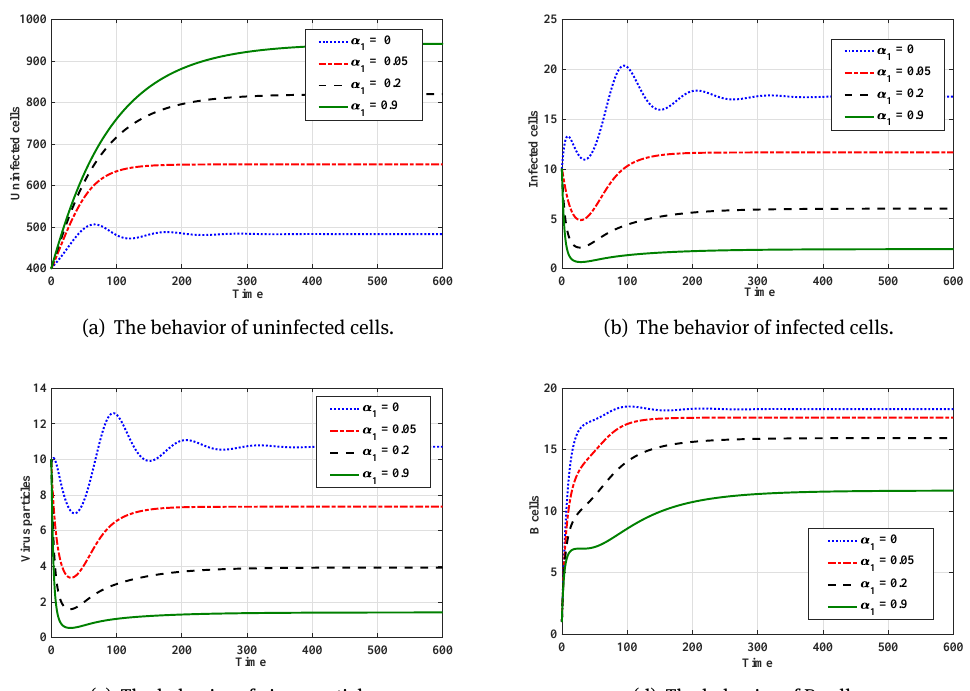
Figure 2: Solution trajectories of system (31)-(34) for different values of α 1 when α 2 = 0